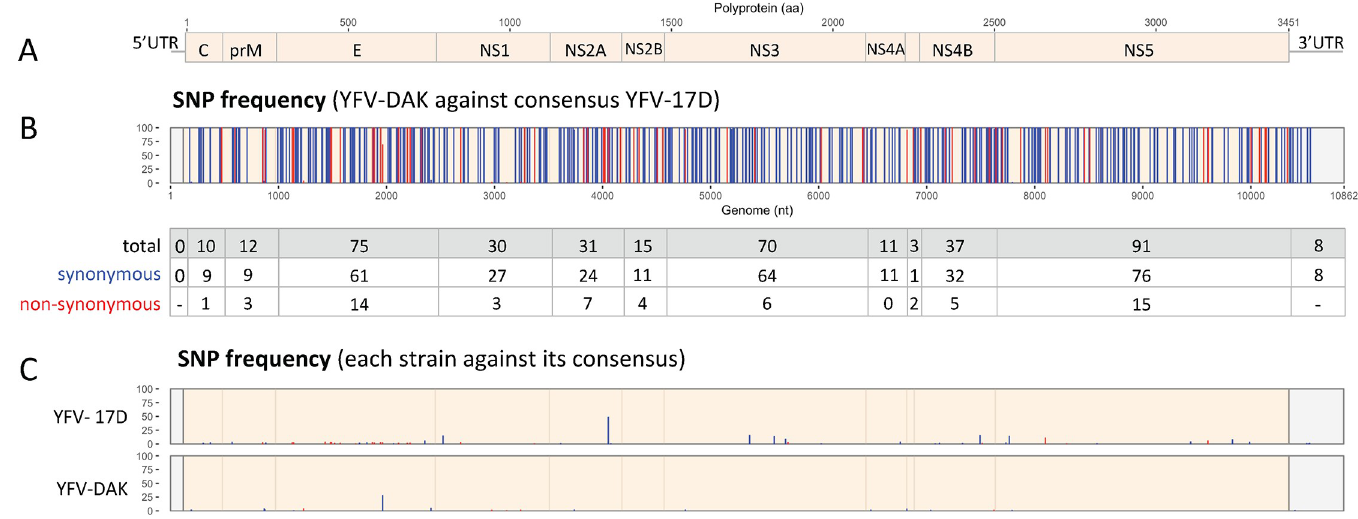
Fig 5. Sequencing and single-nucleotide polymorphism frequency of YFV-17D and YFV-DAK. (A) Schematic representation of YFV genome. (B) Single-nucleotide polymorphism (SNP) frequency between YFV-Dakar and the consensus sequence of YFV-17D are shown. Blue and red bars represent synonymous and non- synonymous variants, respectively. The table shows the number of SNP per coding or non-coding region. Only SNPs of more than 3% were represented. (C) Genomic intra-variability of YFV-17D and YFV-DAK. SNP frequency were obtained using the respective consensus sequence of each strain as a reference.